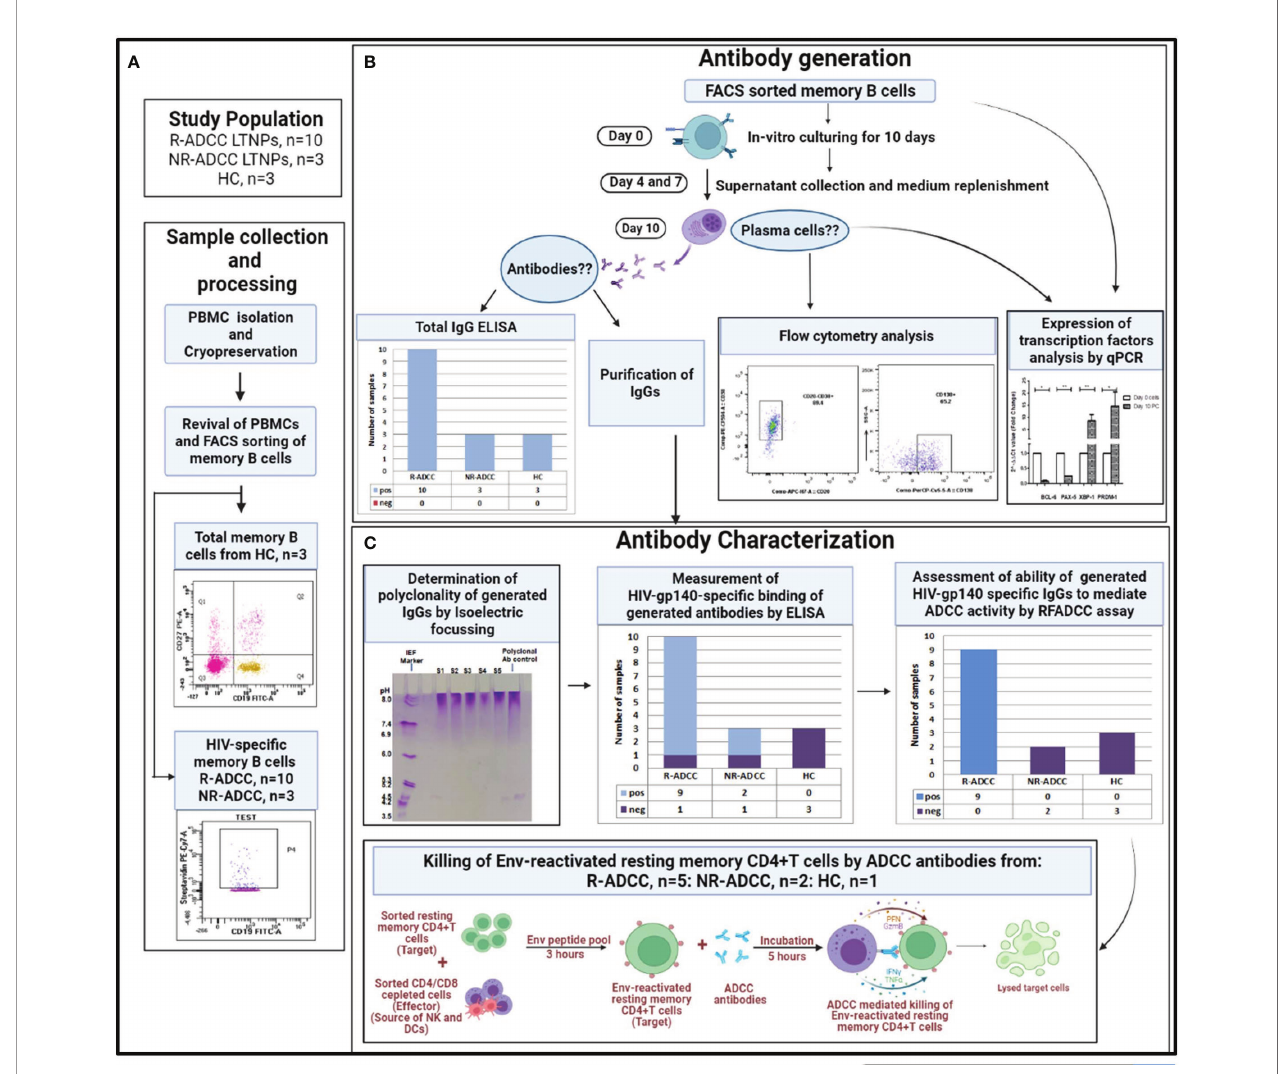
FIGURE 1 | Summary of the experimental work fl ow of the study. (A) Whole blood samples were collected from long-term non-progressors (LTNPs) with and without plasma antibody-dependent cellular cytotoxicity (ADCC) activity (R-ADCC, n = 10 and NR-ADCC, n = 3, respectively) and 3 healthy individuals (HCs) and processed for the separation and cryopreservation of peripheral blood mononuclear cells (PBMCs). The PBMCs were then revived and memory B cells from three HCs and HIV-speci fi c memory B cells from R-ADCC ( n = 10) and NR-ADCC LTNPs ( n = 3) were FACS sorted. (B) Antibody generation: the FACS-sorted memory B cells from all the samples were cultured for 10 days. On day 10, supernatants were assessed for the presence of antibodies and were then column puri fi ed. The cells were assessed for the differentiation into plasma cells by fl ow cytometry and real-time PCR analysis at day 10. (C) Antibody characterization: the generated antibodies were then assessed for the presence of gp140 antibodies using ELISA, their ability to mediate ADCC using rapid fl uorometric antibody-dependent cellular cytotoxicity (RF-ADCC) assay, and their ability to facilitate NK cell-mediated lysis of Env-reactivated latent reservoirs using a fl ow-based latency reduction assay as reported earlier